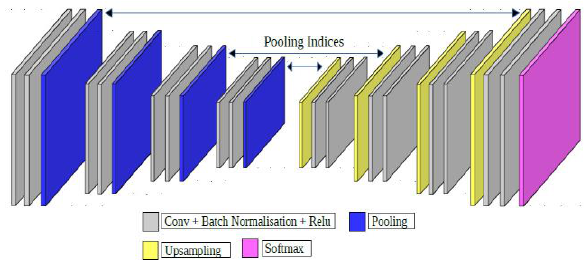
Figure 3. SegNet architecture composed of encoder and decoder. The encoder extracts a low-resolution feature map and the decoder upsamples it to obtain a pixel-wise classification.